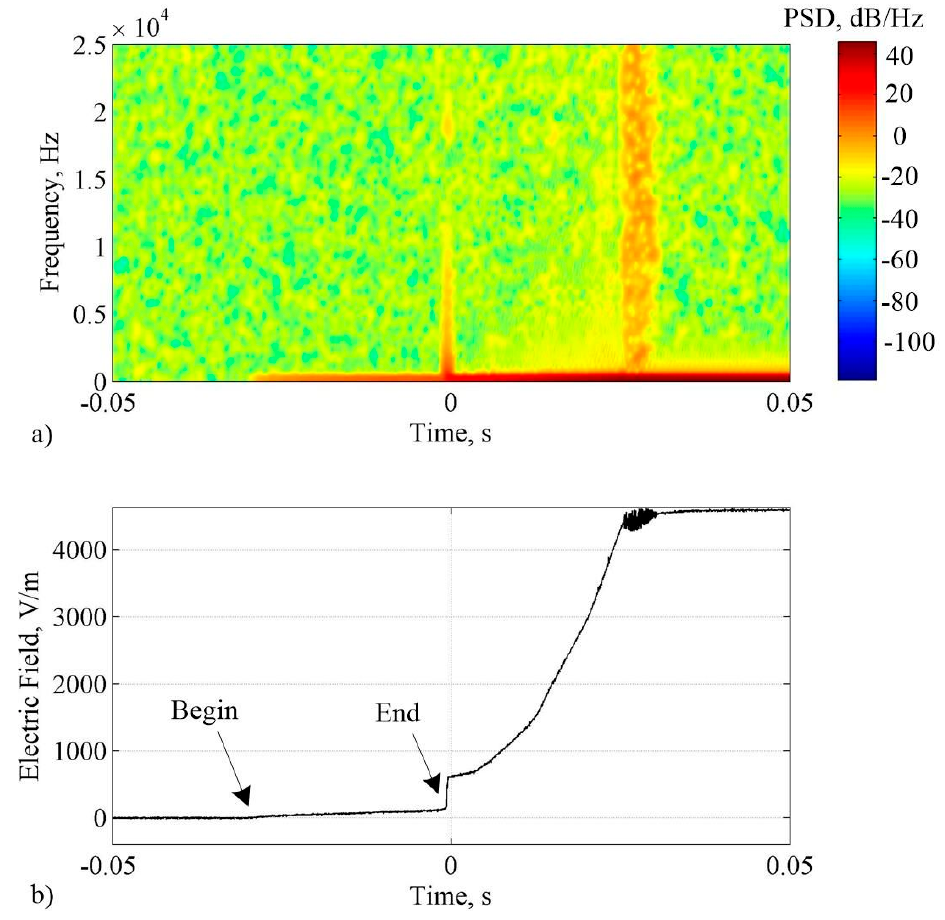
Figure 7. Description is the same as in Figure 4, except for the parameters of Case #3 given in Table 1.